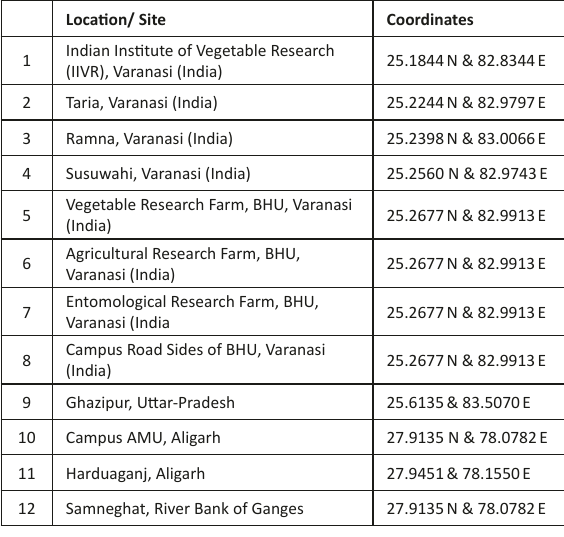
Table 1. Details of survey locality Location/